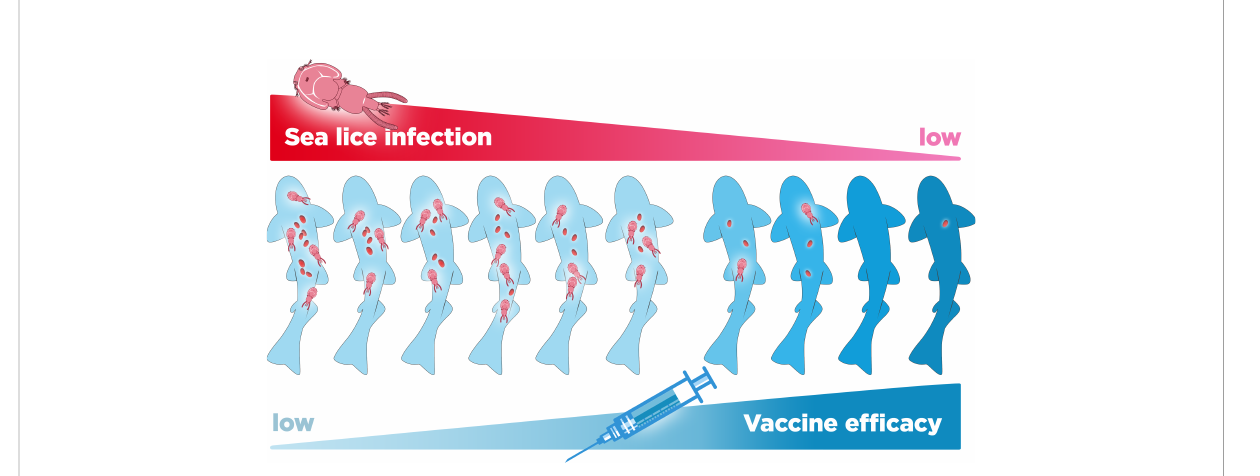
FIGURE 5 Relationship between level of infestation with the sea lice Caligus rogercresse yi and the loss of ef fi cacy of vaccines against Piscirickettsia salmonis in farmed